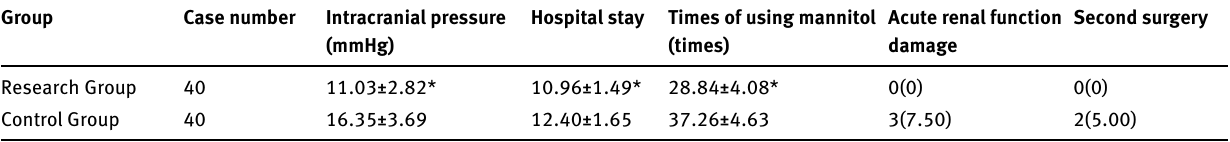
Table 3 Comparison of intracranial pressure, hospital stay, times of using mannitol, acute renal function damage and second surgery between patients of the two